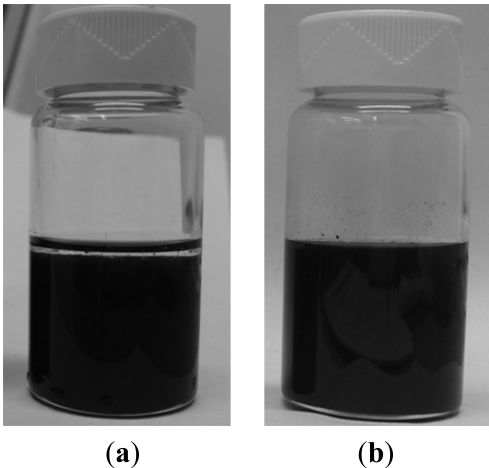
Figure 4. Vial images showing effect of PDMS on dispersion state of MWCNTs in chloroform solution: ( a ) PDMS added into dispersed MWCNTs-chloroform solution, staying on top portion and ( b ) Chloroform solution containing PDMS and MWCNTs 42 h after